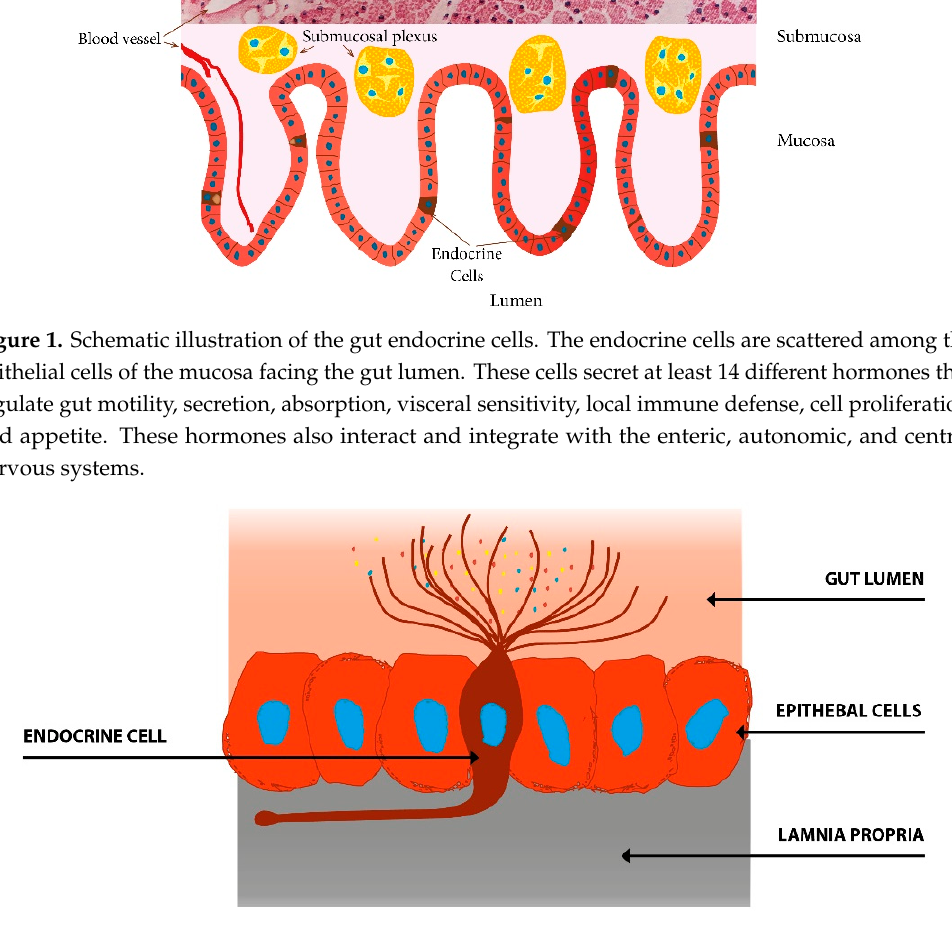
Figure 3. Duodenal cholecystokinin (CCK) cells of a healthy subject ( A ) and of a patient with irritable bowel syndrome (IBS) ( B ). Patients with IBS have a low density of CCK cells.